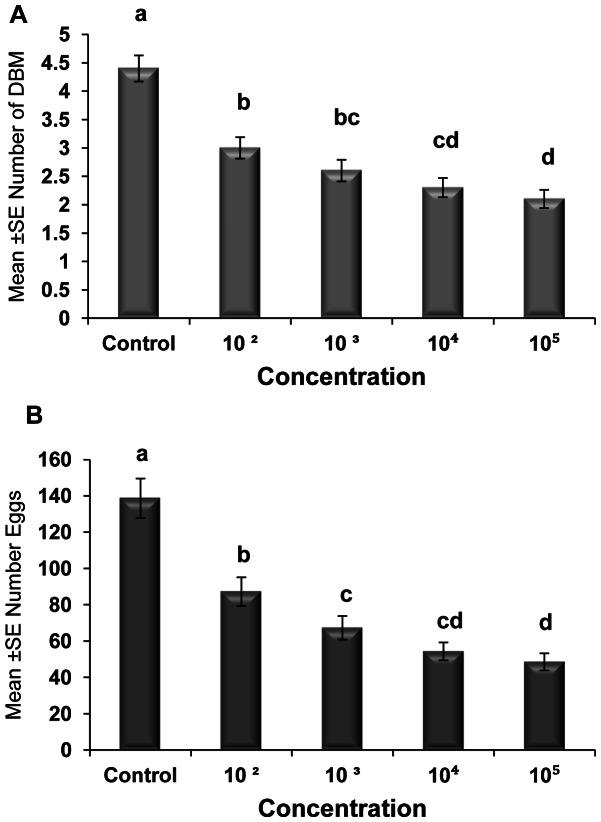
Effect of concentration of Nosema on adult emergence and egg production.Graph bars represent mean ± SE of number of adults emerged (a), number of eggs produced by DBM adults (b) developed from larvae inoculated at different dosages of Nosema sp. spores. Different letters above error bars indicate significant difference (P<0.05).